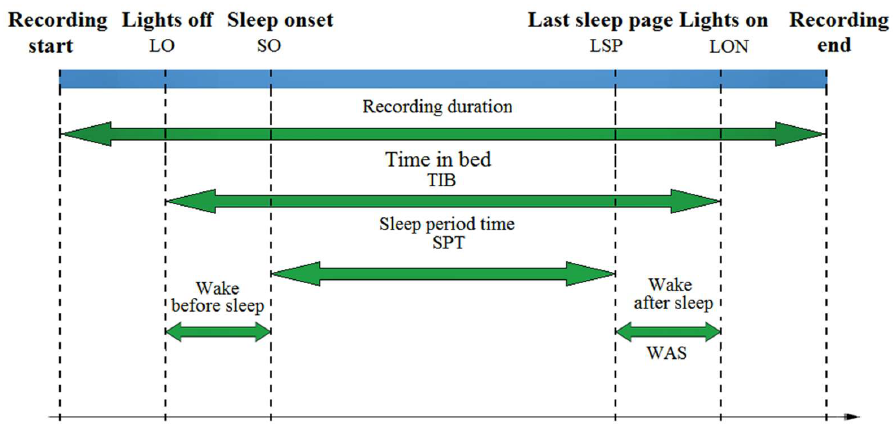
Figure 2. Timing diagram of a sleep data recording with the annotation of the significant sleep events and